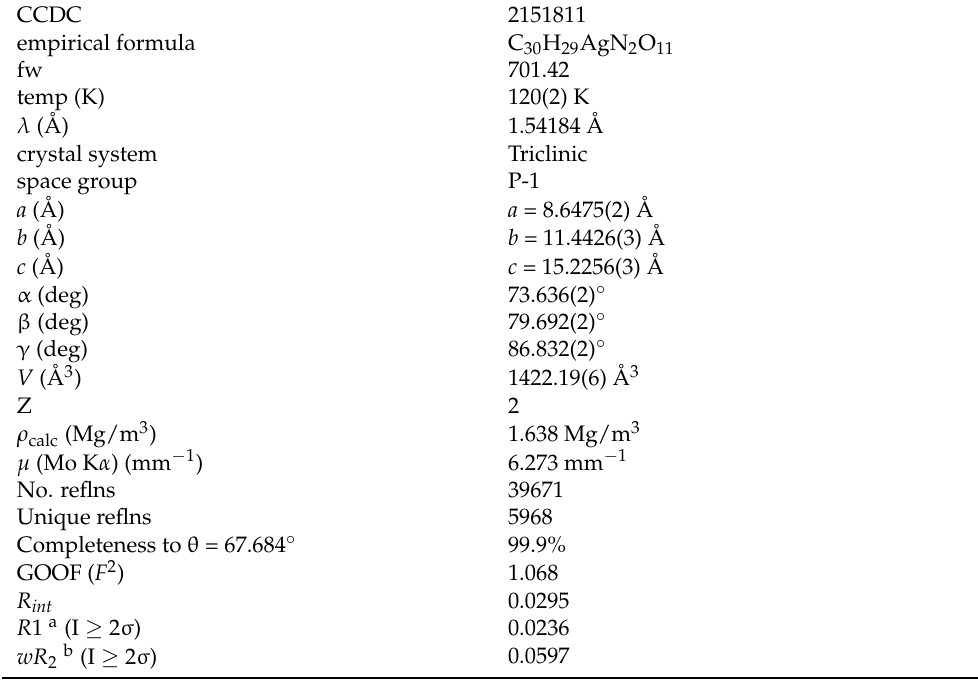
Table 1. Crystal data of [Ag(Et3qu)2(citrate)]